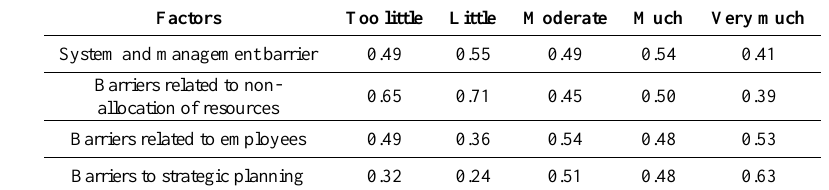
Table 6 . Quantization and non-scalability of the decision matrix.